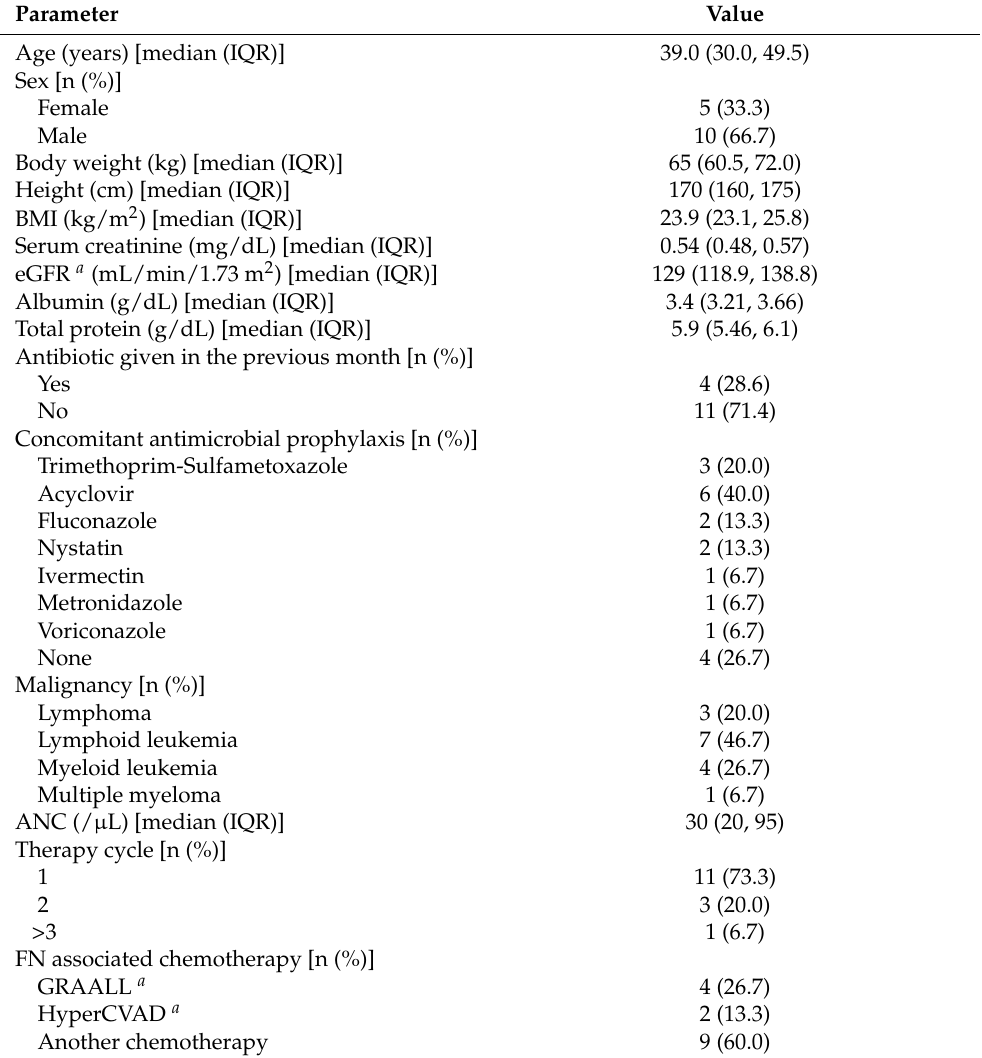
Table 1. Demographic, clinical, and laboratory characteristics of the